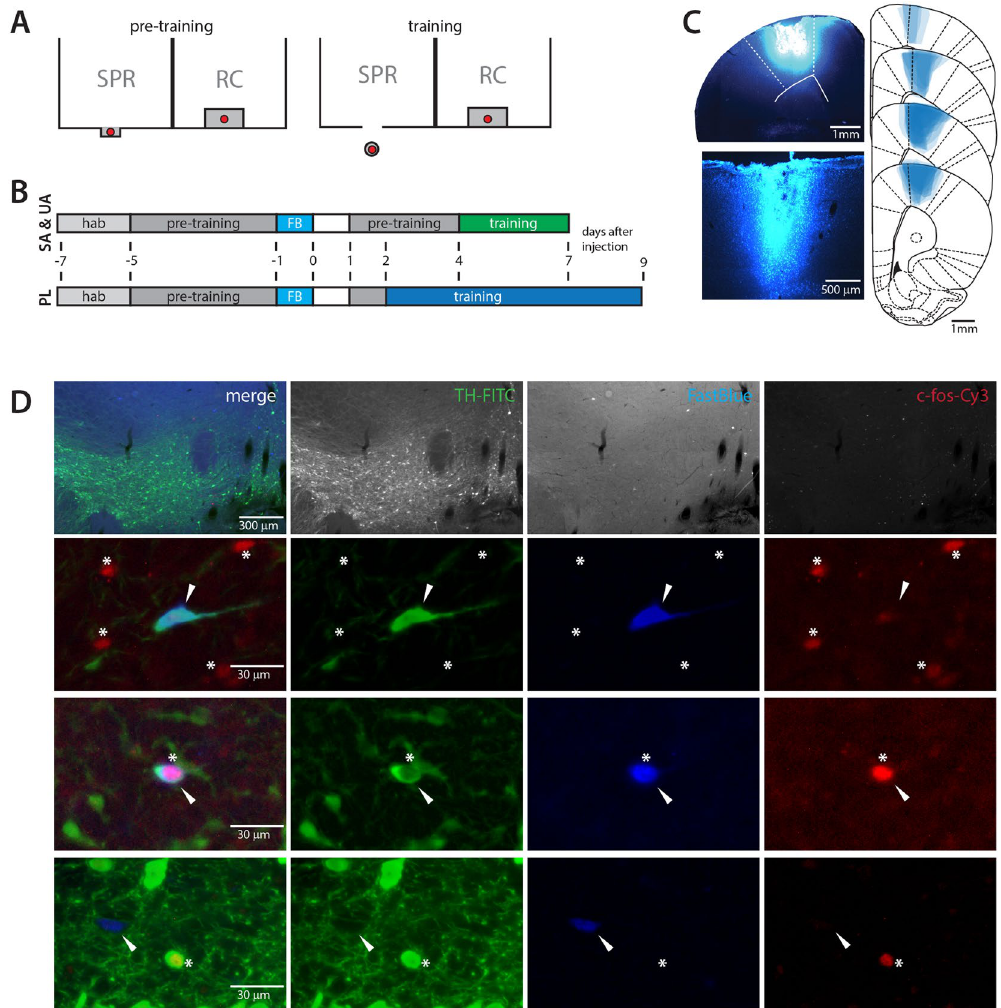
Figure 1. Overview of experimental setup and typical histological results. ( A ) Schematic drawing showing the front of the training apparatus and placement of food pellets (red) during pre-training and single pellet reaching (SPR) training for SPR rats (left part of the cage) and RC rats (right part of the cage). The pellet is placed within tongue-reach for SPR rats during pre-training and on a pedestal, that can only be reached by grabbing during single pellet reaching training. For RC rats, pellets are delivered to the inside of the cage whenever the SPR rat consumes one in both the pre-training and training phase. ( B ) Schematic of experimental setup for successful acquisition (SA), unsuccessful acquisition (UA) and plateau (PL) experiments. Numbers indicate time after FastBlue injection (FB). hab = habituation, training = single pellet reaching training. ( C ) Distribution of FastBlue in M1 after cortical injection. Representative photomicrographs showing dye injection and needle track in cortex (left) and extend of dye spread in sections 2.7-2 mm rostral of bregma (right). ( D ) Representative examples of VTA neurons positive for tyrosine hydroxylase (TH-FITC, green), FastBlue (FB, blue) and/or c-fos (c-fos-Cy3, red). Top row: 10x magnification, bottom rows: 40x magnification. Arrows indicate FB + cell bodies. Asterisks denote position of c-fos +